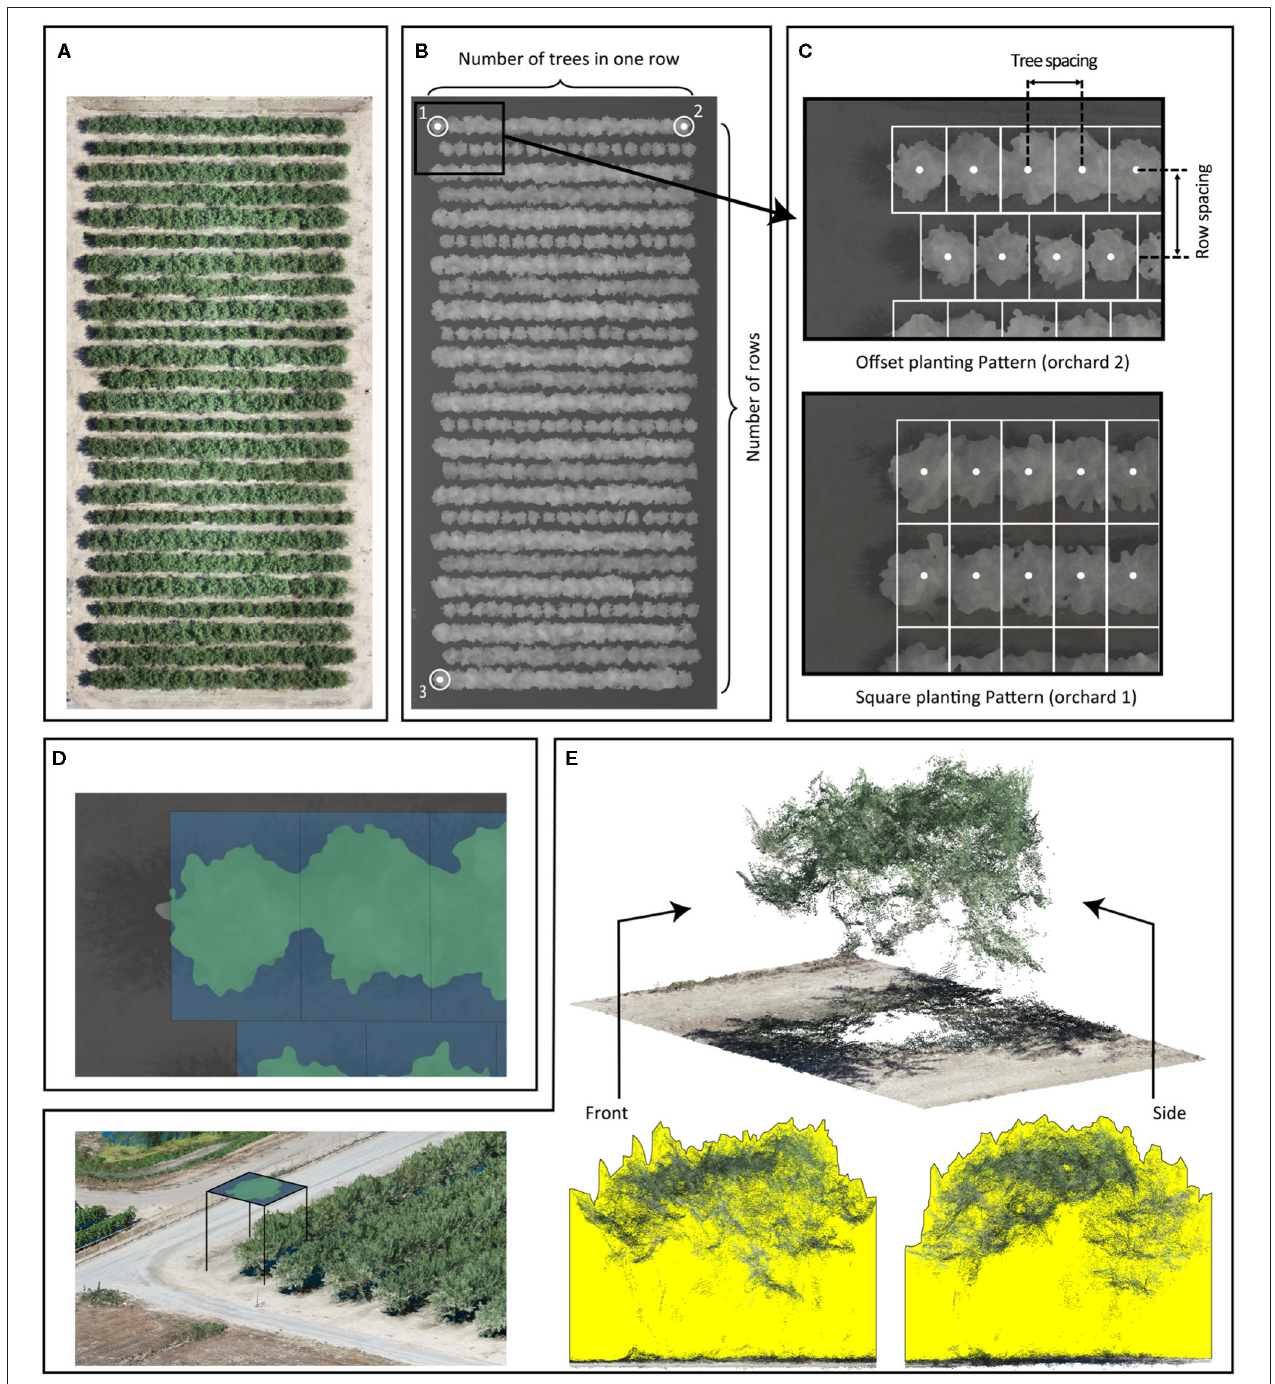
FIGURE 1 | The Virtual Orchard (VO) processing steps: RGB orthomosaic of Orchard 2 (A) ; a digital surface model (DSM) of Orchard 2 and some input parameters such as number of rows, number of trees per row, and coordinates of tree trunk in three corners: for orchard orientation, three points are placed at the orchard map corners (numeric labels), which form two vectors describing the orientation (B) ; additional input parameters including row/tree spacing and planting pattern: the offset planting pattern assumes that tree centers in adjacent rows are offset by half of the tree spacing; the square planting pattern assumes that tree centers in adjacent rows are aligned. Tree spacing and row spacing are defined by the distance between the centers of the tree (C) ; canopy cover is the percentage of canopy footprint area in green divided by the canopy allocated area in blue (Equation 1) (D) ; 3D point cloud of trees; canopy volume index is visualized in the front and side cross-sectional views of a point cloud generated from photogrammetry for one example tree. The yellow areas represent the front and side cross-sectional views of the volume calculated in the canopy volume index (Equation 2) (E) .